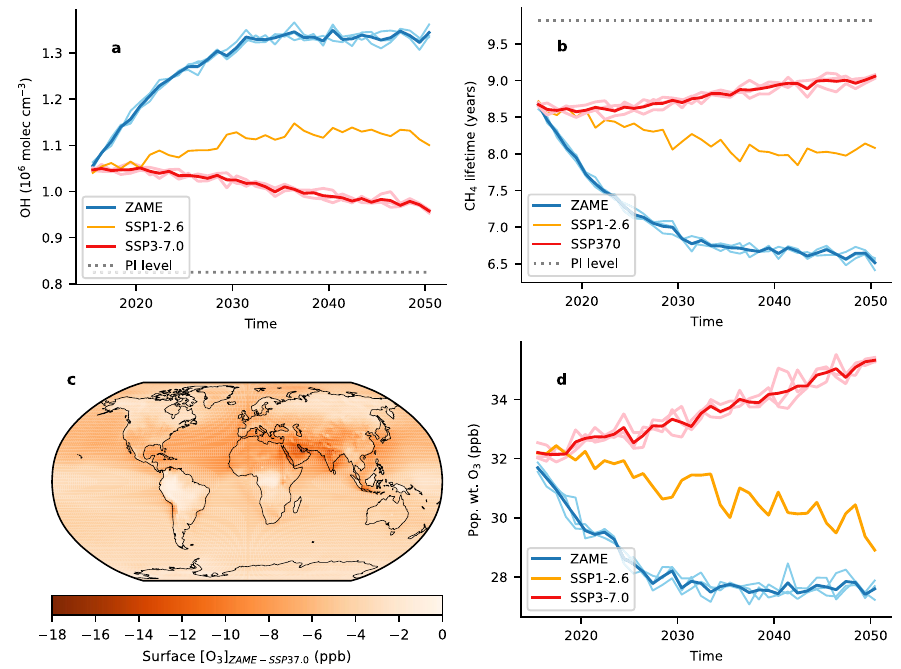
Fig. 2 Atmospheric composition changes over time in the zero anthropogenic methane scenario (ZAME) from 2015 to 2050. The SSP3- 7.0 scenario is shown in red, ZAME in blue, SSP1-2.6 in orange and pre-industrial values in dotted grey. The fainter coloured lines show the three individual ensemble members and the darker line shows the ensemble mean, for SSP3-7.0 and ZAME. a Global mean (airmass-weighted) tropospheric OH concentration. b Methane lifetime, de fi ned as total atmosphere burden divided by CH 4 -OH fl ux in the troposphere. c Decadal mean (2040 – 2050) change in surface ozone concentrations in ZAME compared to SSP3-7.0. d Population-weighted surface ozone concentration. Population datasets are based on the underlying SSP scenarios 46 . The tropopause is de fi ned as a [O 3 ] = 125 ppb